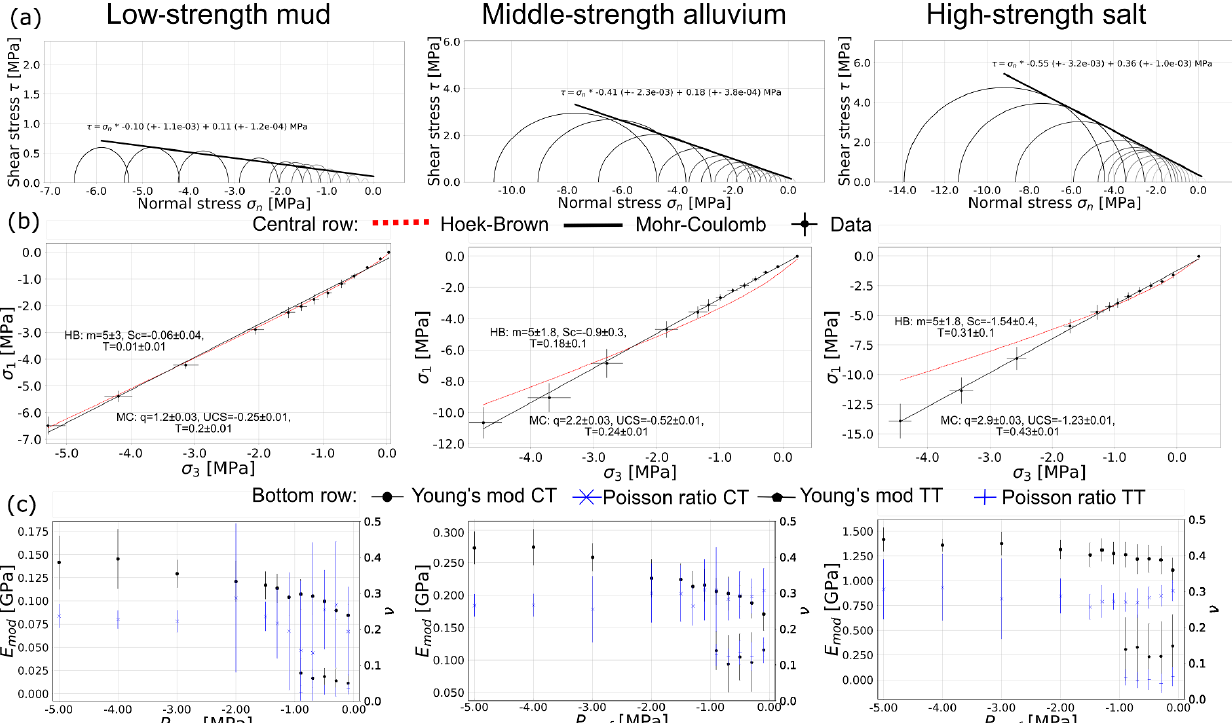
Figure 7. Bulk failure envelopes and elasticity parameters of the simulated Dead Sea materials derived from simulated laboratory tests. (a) Mohr–Coulomb failure envelopes, (b) Mohr–Coulomb and Hoek–Brown principal stress, (c) variation of elastic parameters with confining pressure. Left column: low-strength cohesive lacustrine mud; central column: middle-strength alluvial sandy gravel material; right column: higher-strength Holocene salt. CT indicates compression test data; TT indicates tension test data.